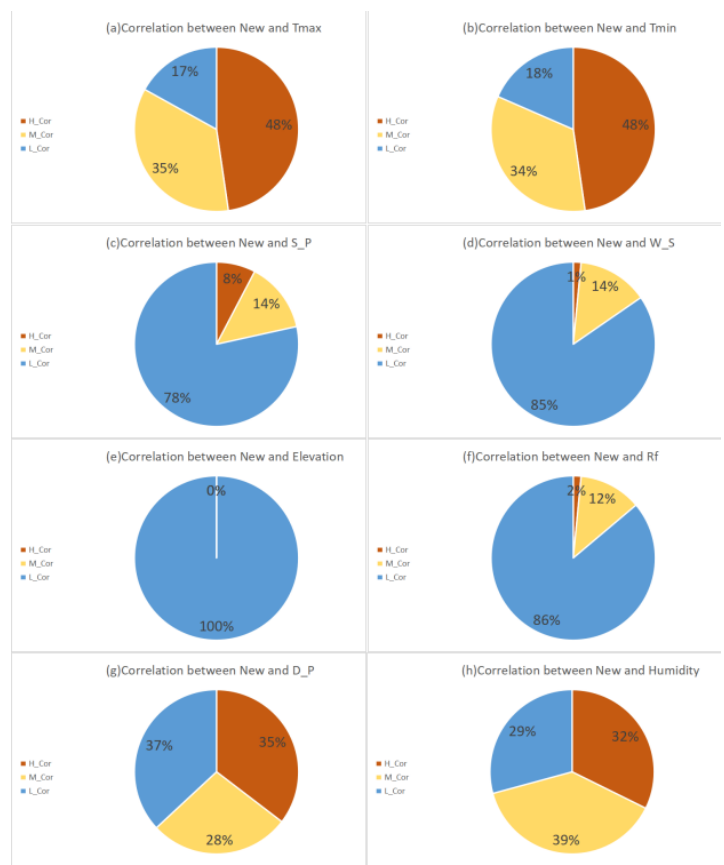
Figure 2. Correlations between the number of daily new confirmed cases and climate variables.